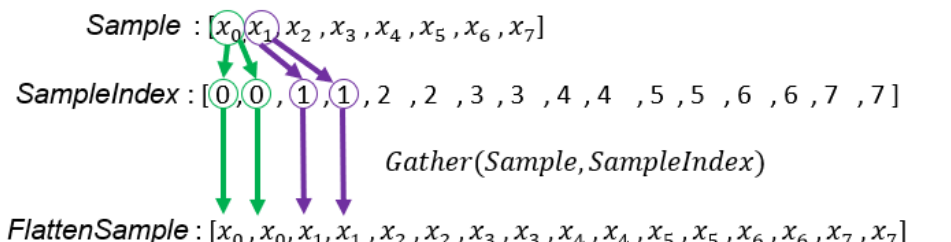
Figure 7. The generation process of FlattenSample . For example, x 0 is copied twice because each GMM has two Gaussian components and each sample will be accessed to compute Resp .